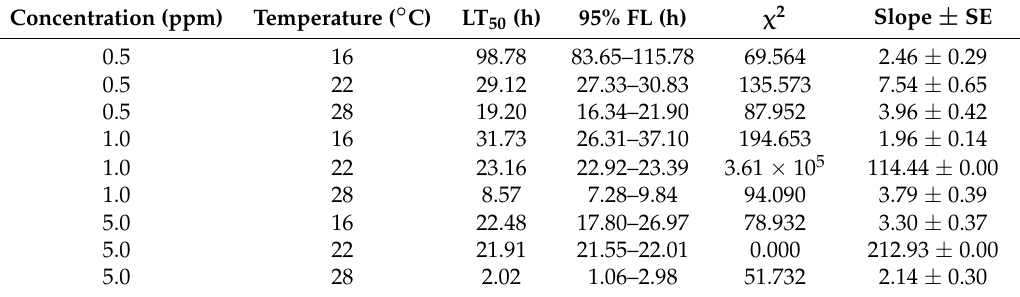
Table 2. Effect of concentration and temperature on mortality of Formosan subterranean termites, C. formosanus , exposed to